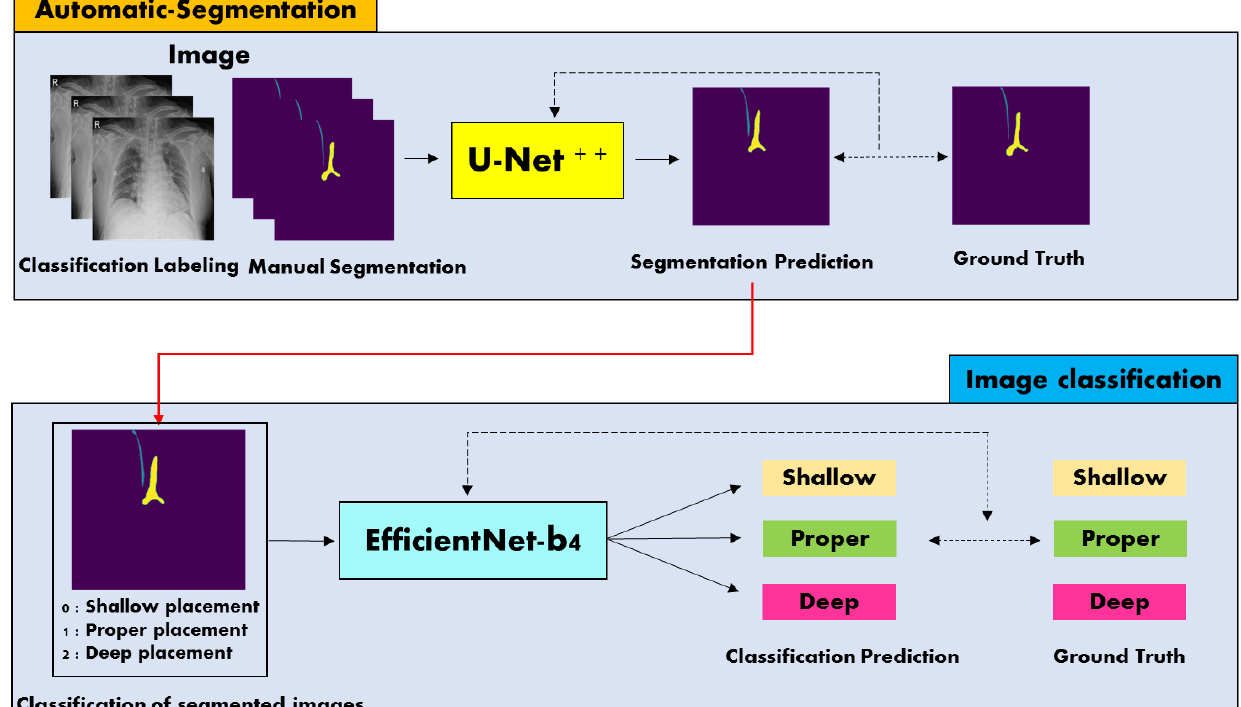
Figure 2. Work flow of our segmentation model of the trachea and CVC as well as three-class problem for correct position of the CVC tip on chest radiographs. U-net ++ generates segmentation results as binary images. These binary segmentation images are fed into EfficientNet-b4 as an additional input to enhance the classification accuracy of the three-class problem of CVC position.